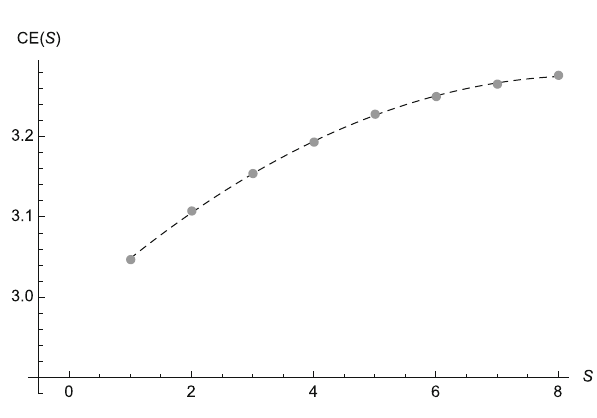
Fig. 2 CE of the tensor family as a function of the S spin